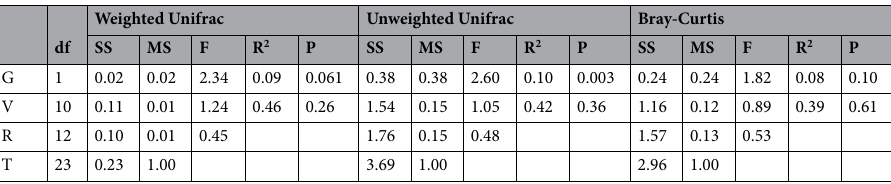
Table 2. Genotype-dependent differences in fecal microbiota composition of control and park 25 mutants. Effects of fly genotype (G), fly vial (V), residuals (R), and totals (T) as determined by PERMANOVA. PERMANOVA values are degrees of freedom (df), sum of squares (SS), mean squares (MS), F statistic (F), R 2 value ( R 2 ), and P -value ( P